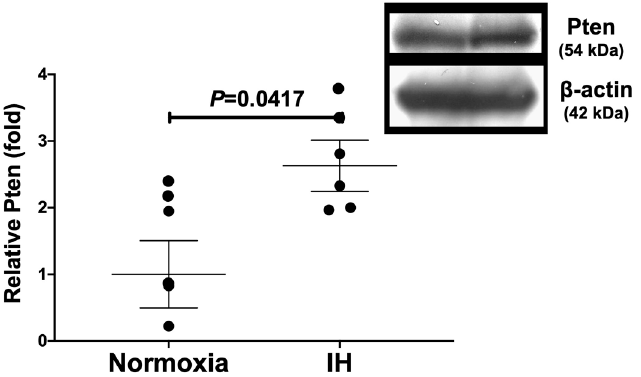
Figure 6. Relative protein expression of Pten in rat H9c2 myocytes subjected to IH. The Pten band densities were quantified through image analysis and then normalized to β‐ actin, as measured in the same blot. The protein level exposed to normoxia was set to 1.0. Each bar represents the mean value of six independent experiments ( n = 6). The relative expression of the Pten is arbitrarily presented. The results are expressed as mean ± SE in arbitrary units. A representative immunoblot with the apparent molecular weight is also shown in the right panel.